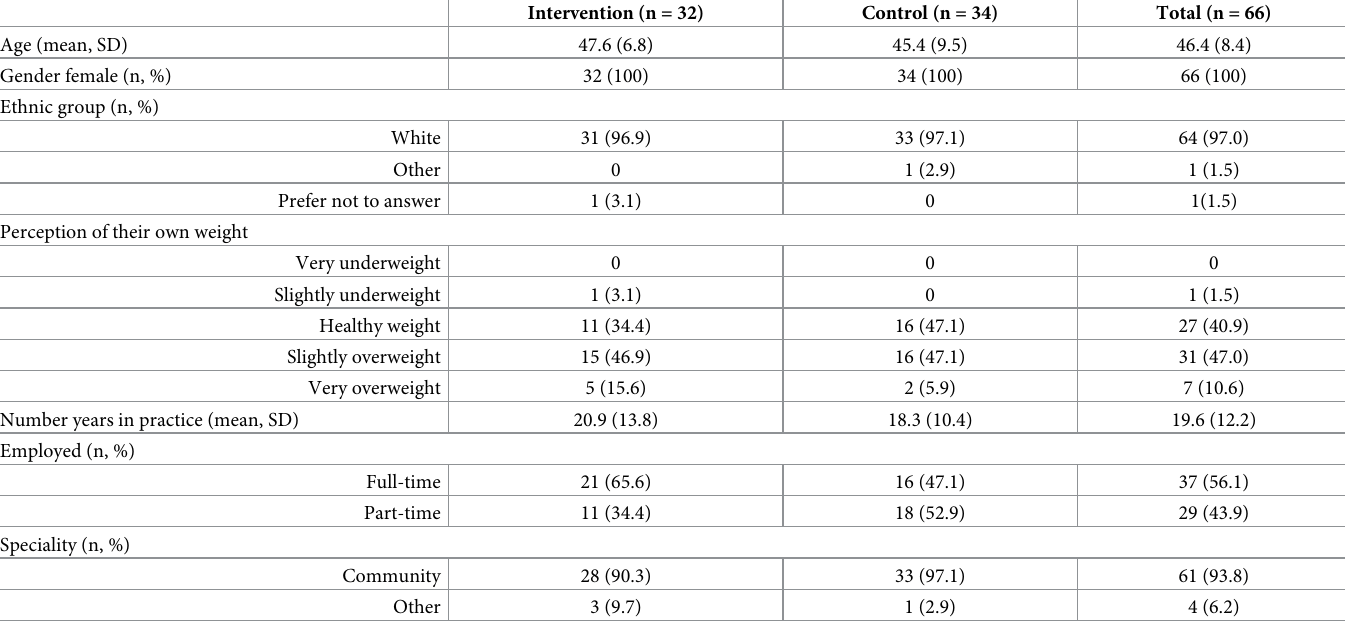
Table 1. Personal and professional characteristics of midwives completing pre-intervention